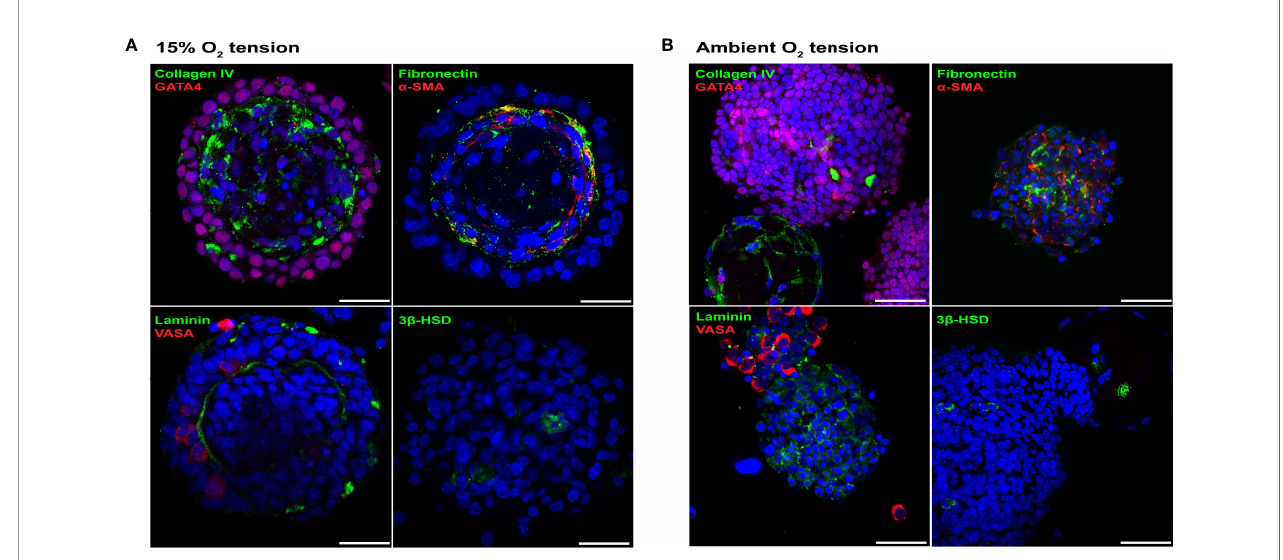
FIGURE 1 | Rat testicular organoids cultured at 15% O 2 tension maintained organotypic morphology. (A, B) Immuno fl uorescence images of day 6 rat testicular organoids at 15% (A) and ambient (B) O 2 tensions showing the distribution of basement membrane (collagen IV, fi bronectin, laminin), Sertoli cells (GATA4), peritubular myoid cells ( a -SMA), germ cells (VASA) and Leydig cells (3 b -HSD). Scale bars measure 25 m